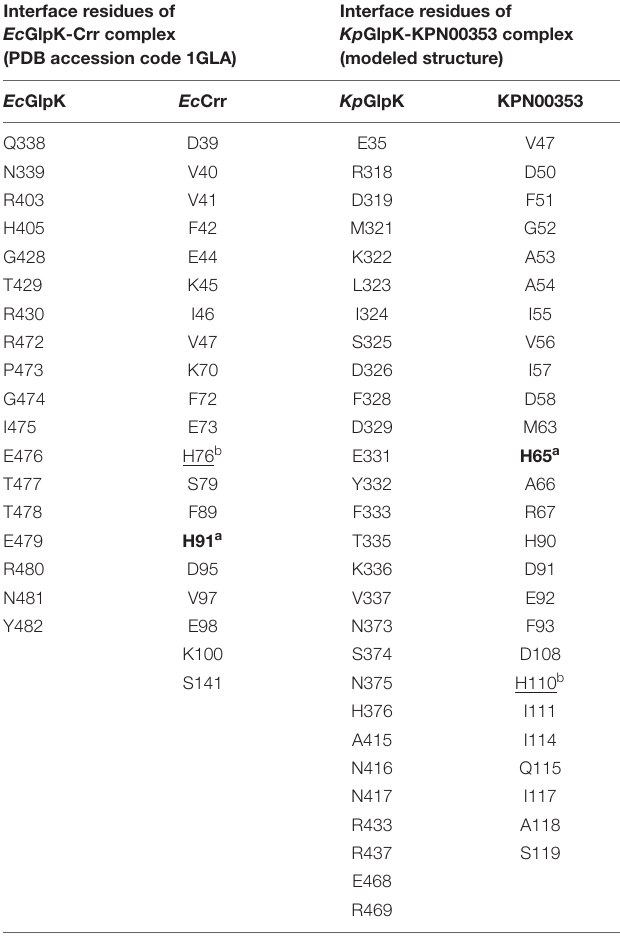
TABLE 2 | The interface residues of the E. coli GlpK-Crr complex (solved structure, PDB accession code 1GLA) and the K. pneumoniae GlpK-KPN00353 complex (modeled structure).